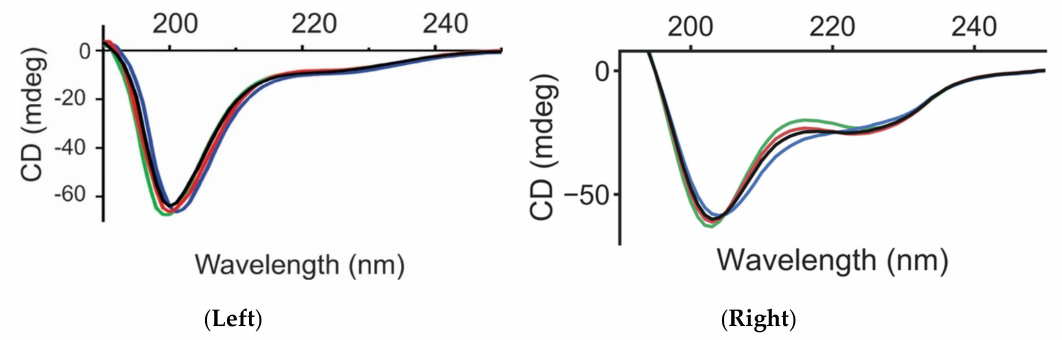
Figure 1. The position-39 α S variants are largely disordered in the monomeric state. The far-UV circular dichroism (CD) spectra of wt (black), Y39F (blue), Y39A (red), and Y39L (green) α S monomers show spectral features that are characteristic of random coil conformations ( Left ). In comparison, the predicted CD from the molecular ensemble for the four variants is also shown ( Right